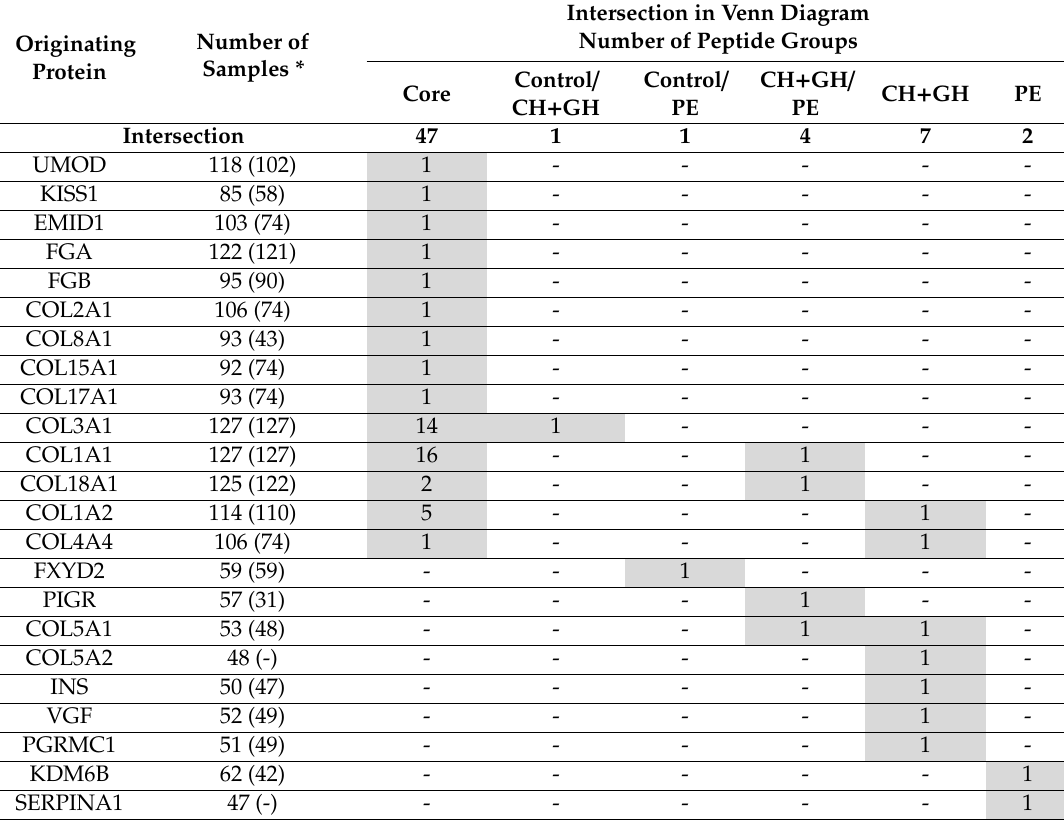
Table 3. Protein a ffi liation of the 62 substantial peptide groups in urine of pregnant women.